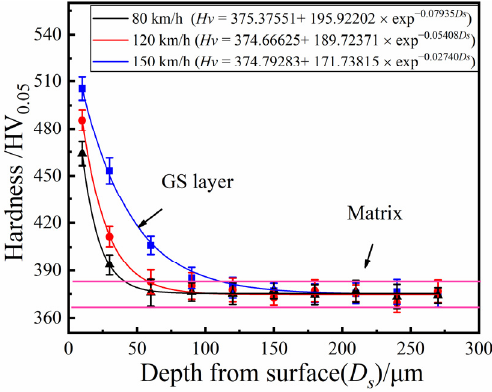
Figure 9. Curves of the distribution of hardness.